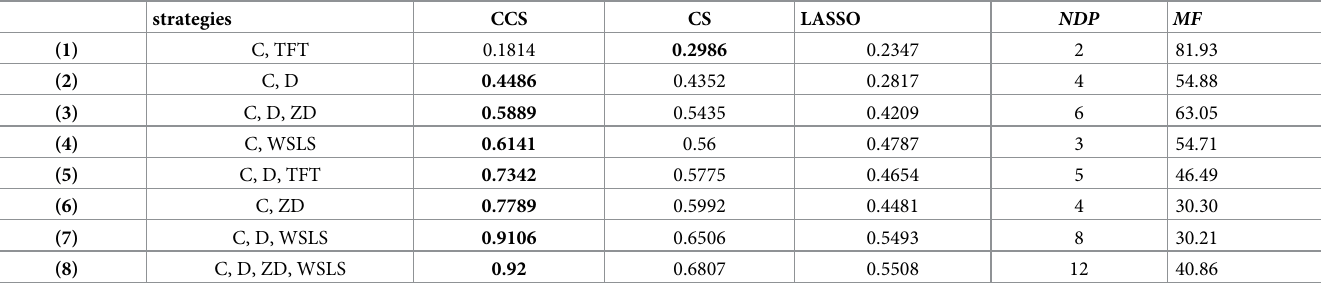
Table 5. The succeed rate ( SR ) of three methods under different strategy combinations. strategies